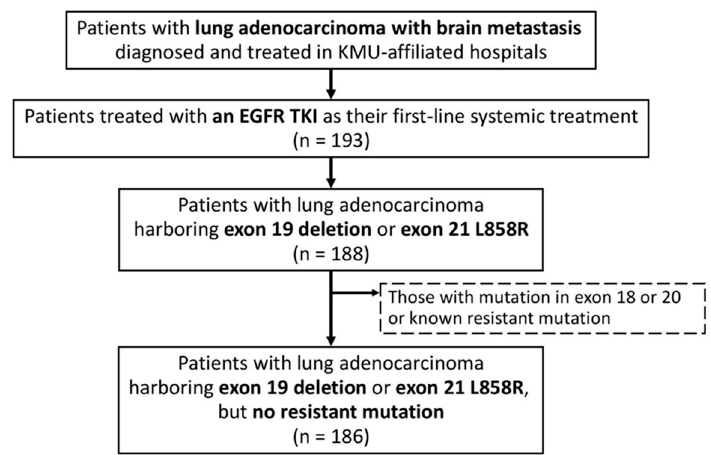
Figure 1. Flowchart for identifying the study population. Abbreviations: EGFR, epidermal growth factor receptor; KMU, Kaohsiung Medical University.